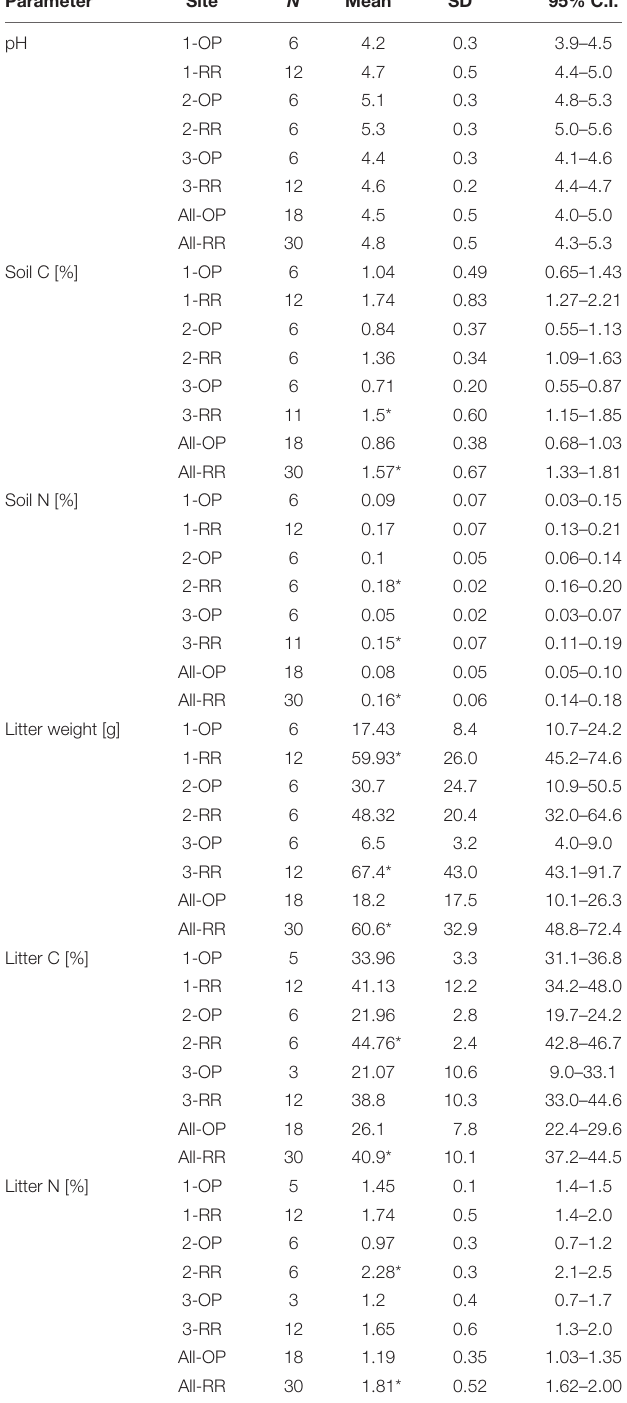
TABLE 1 | Soil and litter physicochemical parameters by transect (1–3) and land-use (OP, oil palm; RR, riparian forest) from measurements at the last sampling occasion in November 2017 from soil and litter inside the chambers (surface area 0.1257 m 2